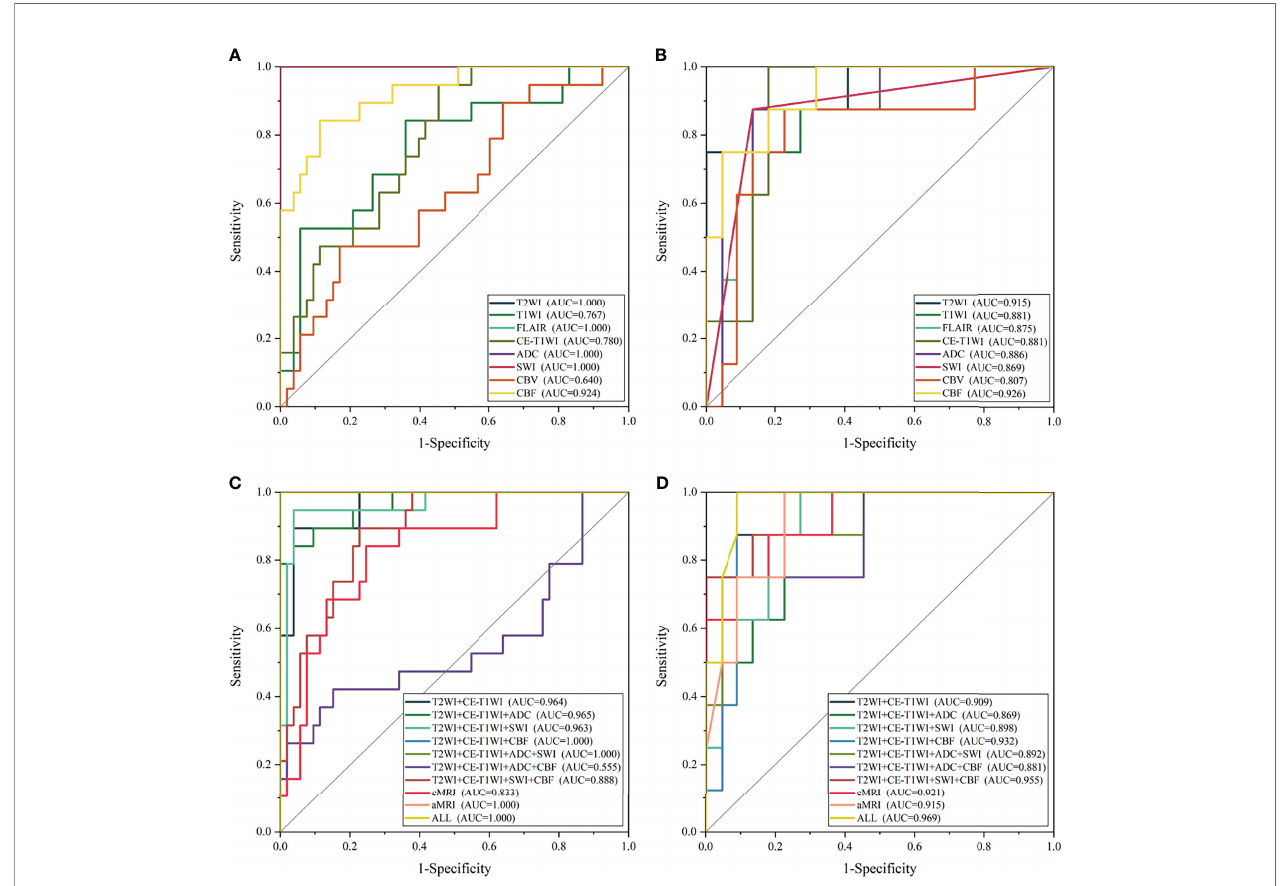
FIGURE 4 | The receiver operating characteristic curve of the top-one-performing models of different sequences in the training (A, C) and test sets (B, D)